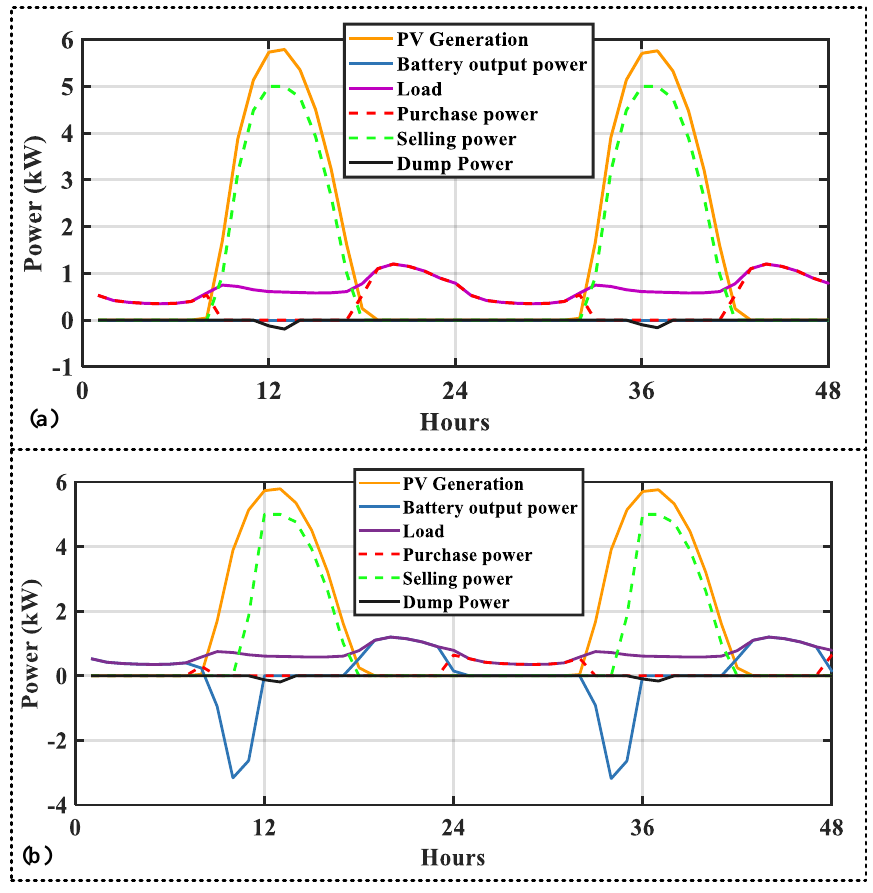
Figure 7. Daily power flow for two sample days in summer using Option 2: ( a ) PV only system; ( b ) PV-BESS system.